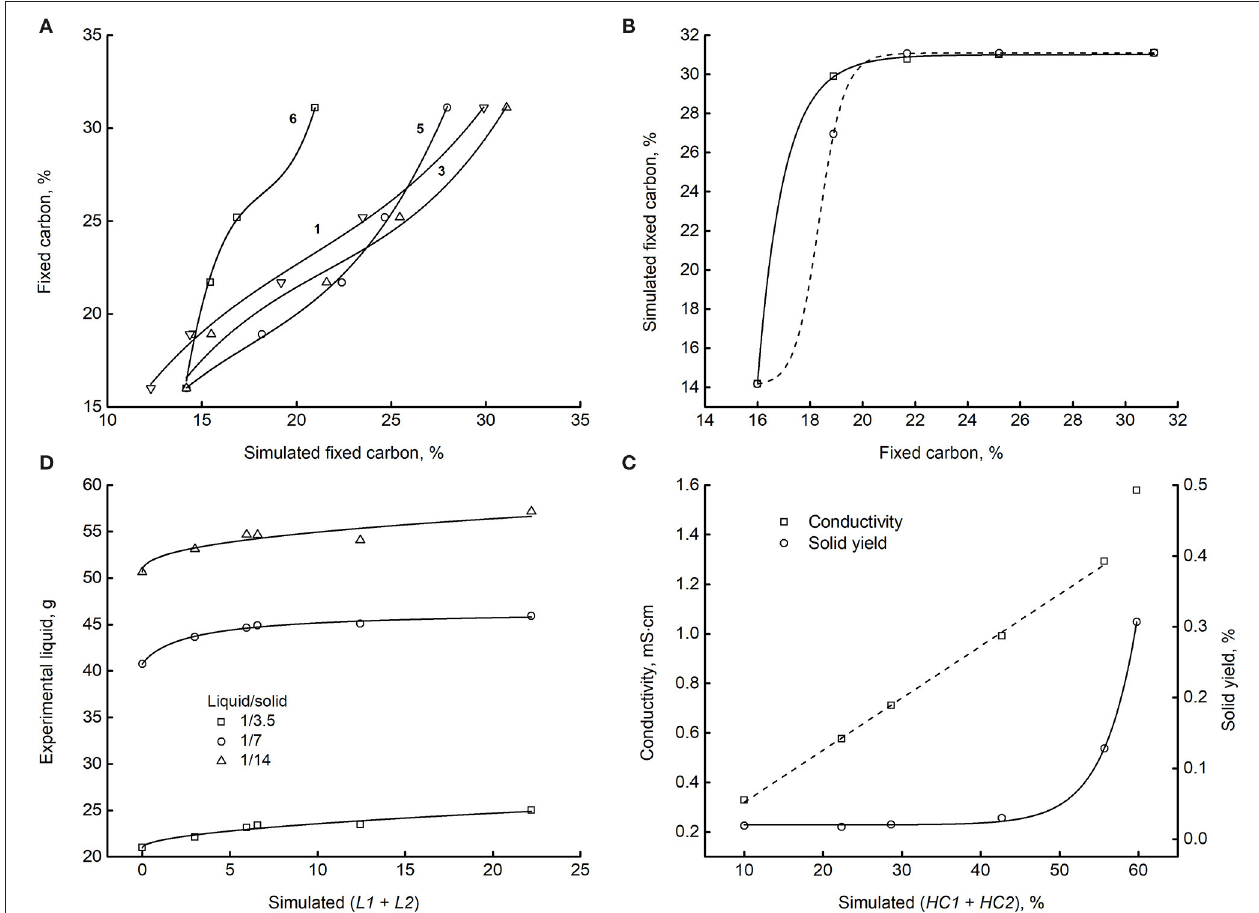
FIGURE 10 | The matching of experiments with simulations. (A) Fixed carbon measured in dataset 2 as a function of the corresponding quantity for some reaction schemes. The numbers to the left of regression lines label the scheme. (B) Simulated vs. measured fixed carbon for scheme 2 (dashed line) and 4 (solid line). (C) Conductivity (left y-axis) and solid yield (right y-axis) of dataset 20 and 21 vs. the simulation of scheme 3. (D) Amount of liquid phase recovered by the reactor as a function of the corresponding simulation compartments. Datasets: 11, 12, and 13. Reaction scheme